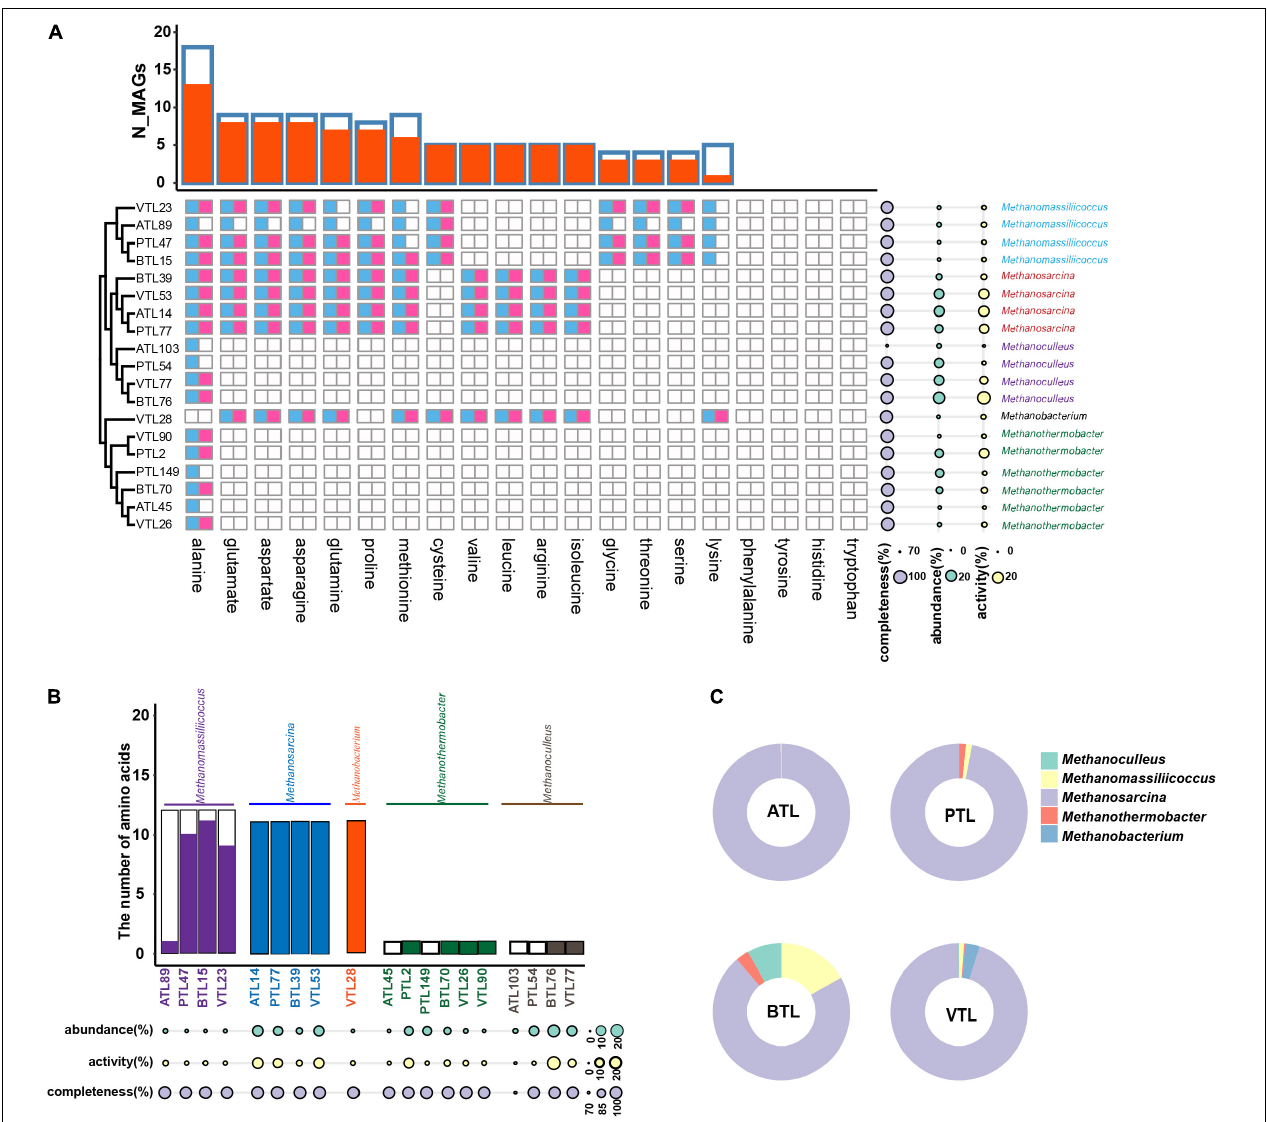
FIGURE 8 | The amino acid synthesis of methanogens in different reactors. (A) The blue squares represent the presence of AA synthesis genes in the corresponding MAGs, whereas the red squares represent the activity of AA synthesis at transcriptomic level. Phylogenetic relationships among these MAGs are shown on the left side. On the right side, the cyan disks represent the abundance of the MAGs, whereas the yellow disks represent their transcriptional activities. The overall landscape of AA synthesis in methanogen MAGs are summarized on the top of the figure. Here, blue frames represent the number of MAGs containing the synthetic genes of the corresponding AA, and the red column represents the number of MAGs that actively transcribed corresponding AA. (B) Summary of the AA synthesis ability of different methanogen taxa. The black frame represents the number of amino acids that the corresponding MAG can synthesize at genomic level, whereas the color-filled column represents the number of amino acids, of which the synthetic genes were actively transcribed in the corresponding MAG. (C) Comparison of relative AA synthesis activity ( RA a . a ) of methanogens from different genera in each chemostat. The ATL, PTL, BTL, and VTL represent the thermophilic methanogenic chemostats supplemented with acetate, propionate, butyrate, and isovalerate as sole carbon source,